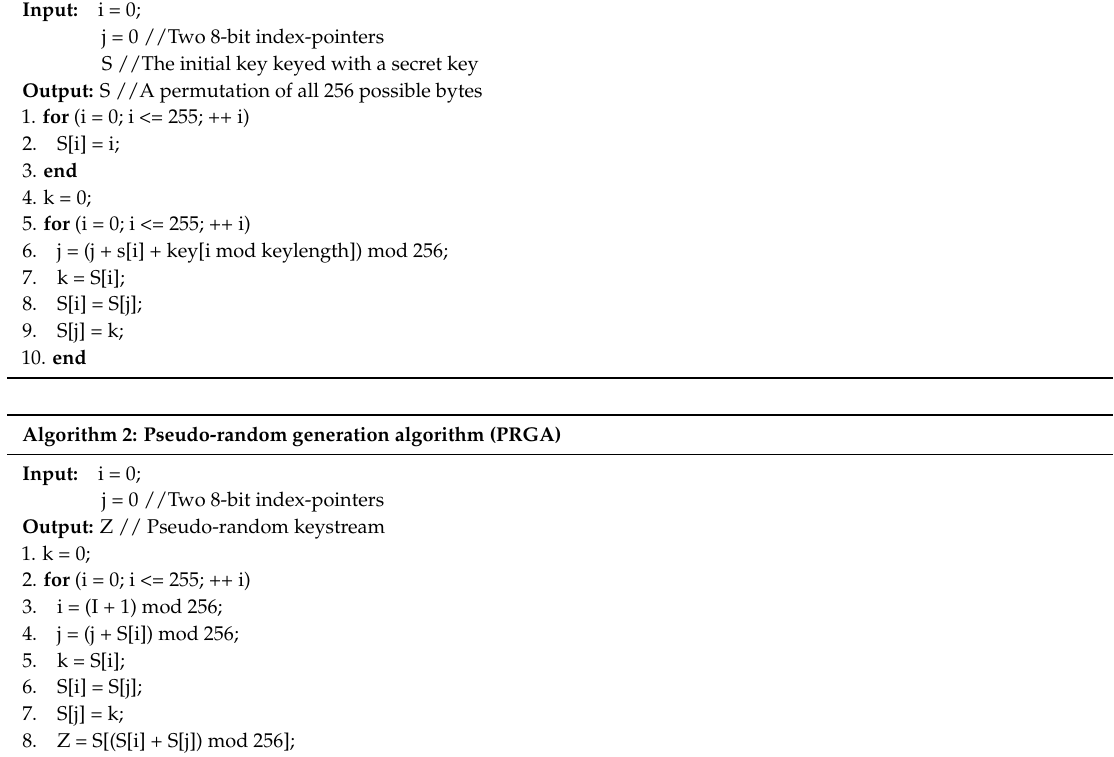
Algorithm 1: Key-scheduling algorithm (KSA)